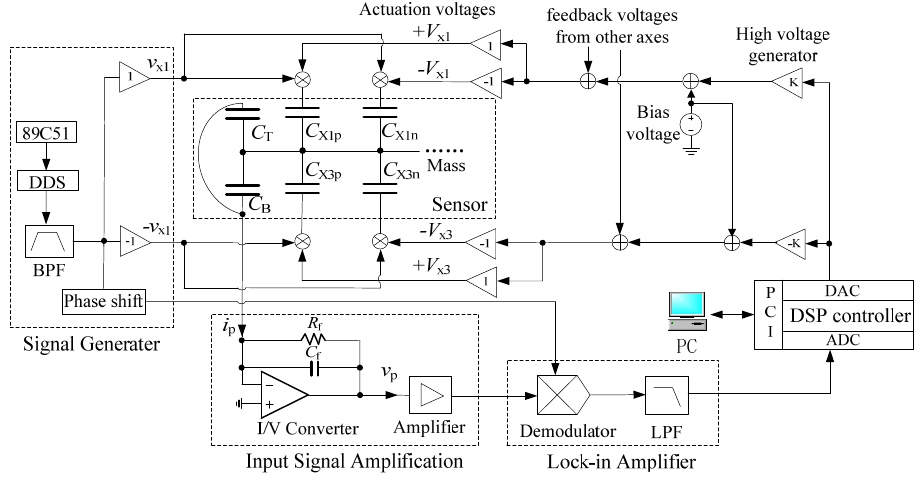
Figure 12. Schematic diagram of detection and control system for the ESMA, taking